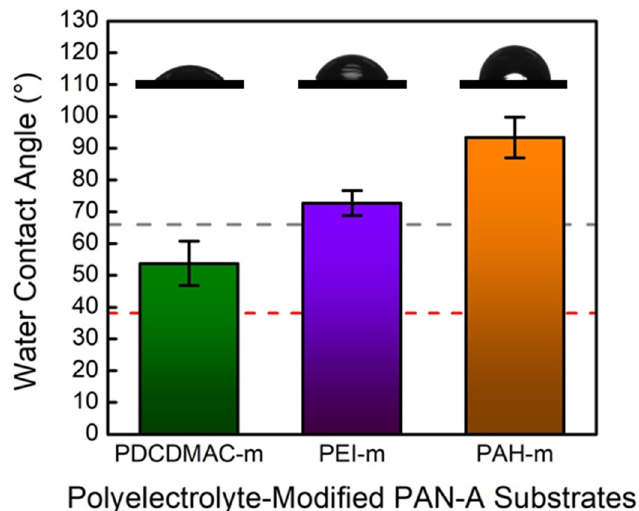
Figure 7. Comparison of the contact angles measured on the surface of the PAN-A substrates modified with the deposition of PDADMAC, PEI, and PAH. The surface modification was implemented by exposing the dense side of the PAN-A substrates to an aqueous solution containing 1 g of the polyelectrolyte and 0.5 M NaCl for 20 min. The gray dashed line marks the average value of the contact angle measured on the surface of the original PAN substrate; the red dashed line marks the average value of the contact angle measured on the surface of the PAN substrate with the alkaline treatment; the error bars correspond to the standard deviations of the characterization results (nine measurements using three membrane samples).